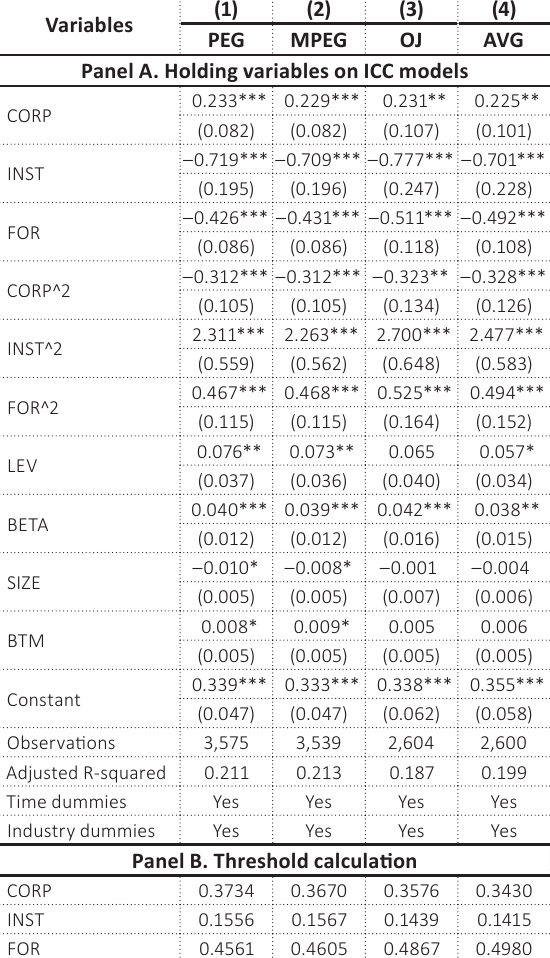
Table 2. Holding variables on ICC models, including the second-order polynomials using pooled OLS